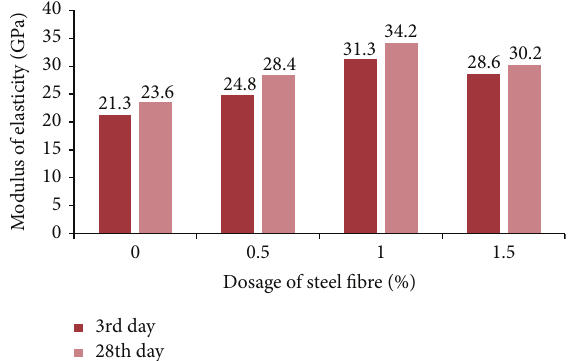
Figure 9: Modulus of elasticity for various volume fractions of steel fibre reinforced slag based geopolymer concrete cubes.